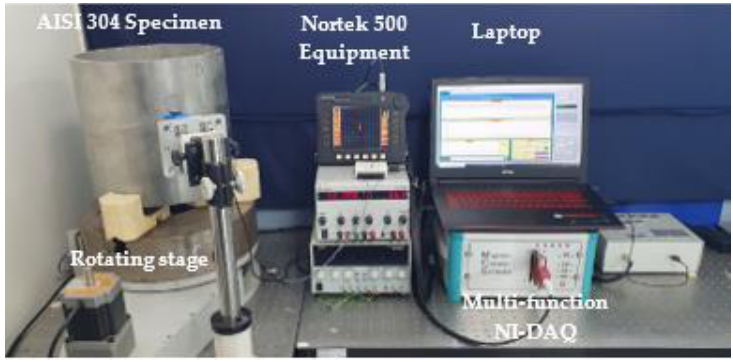
Figure 1. Experimental setup.